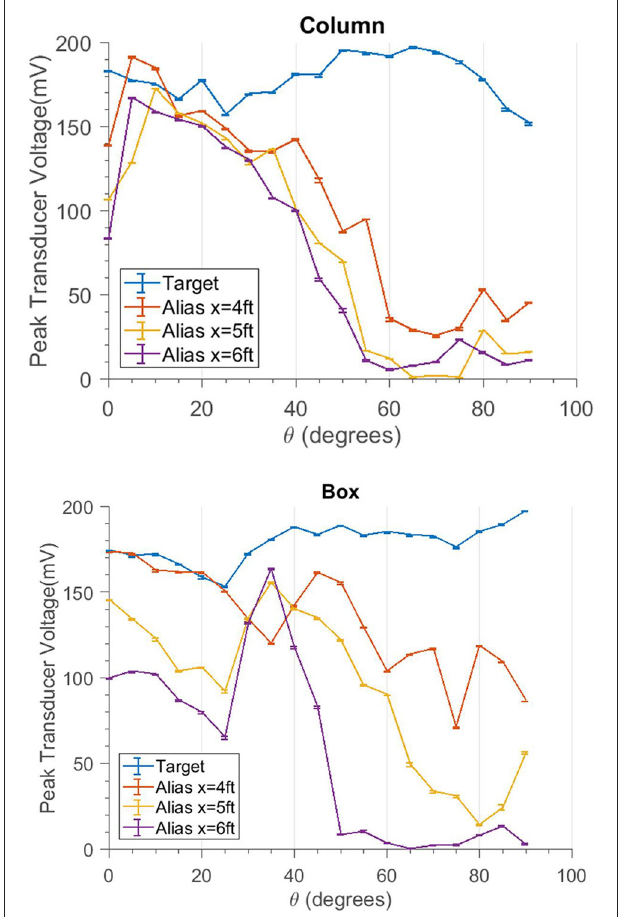
FIGURE 10 | Traces showing the echo response of the target and the alias at different angles. The target trace (blue) gives a baseline for comparison. The “Alias” traces reduce in amplitude as the angle increases. For larger distances x the amplitude decreases even more.